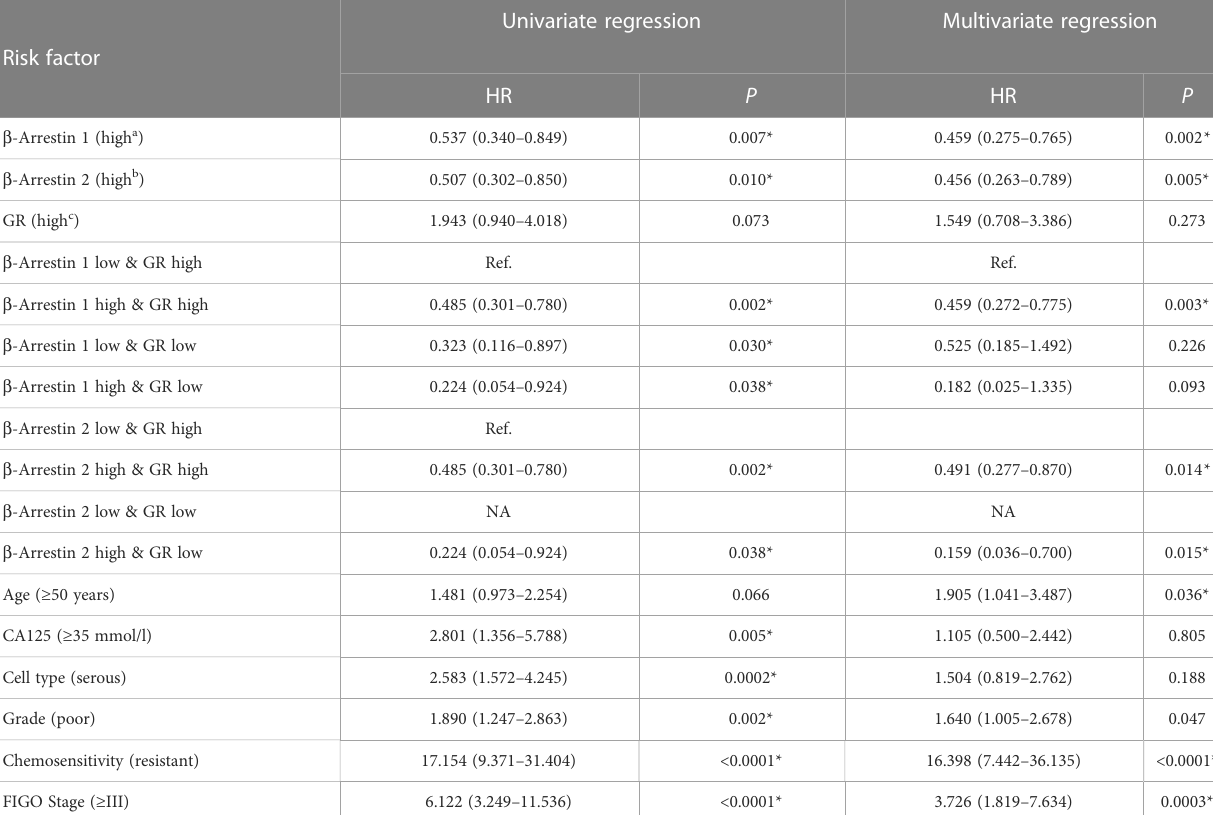
TABLE 2 Associations between prognostic variables and recurrence-free survival in primary epithelial ovarian cancer.